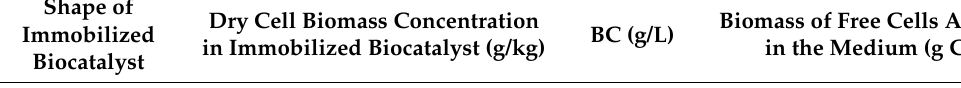
Table 1. The result of the application of immobilized biocatalyst of different shapes containing different concentrations of bacterial cell biomass in the synthesis of BC in an Hestrin–Schramm -medium with 20 g/L of glucose. CDW, cell dry weight. BC, bacterial cellulose.